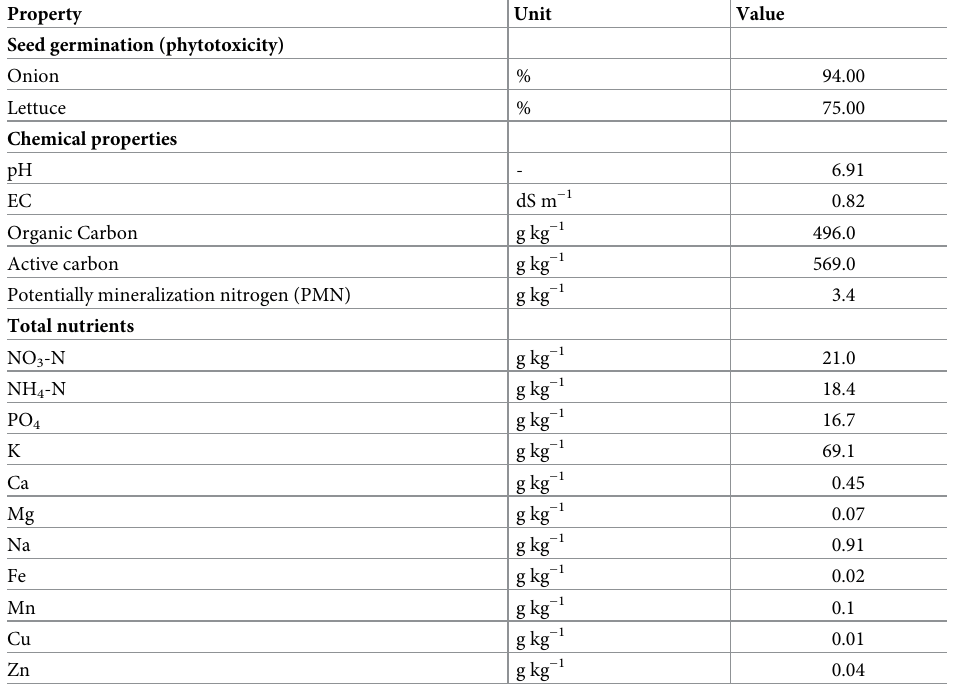
Table 3. Phytotocity test and chemical properties of the eucalyptus-based compost. (n = 4). Property